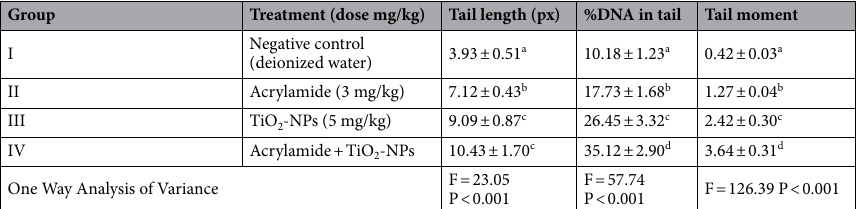
intact appearance of genomic DNA extracted from rain tissue of control mice (Fig. 4).